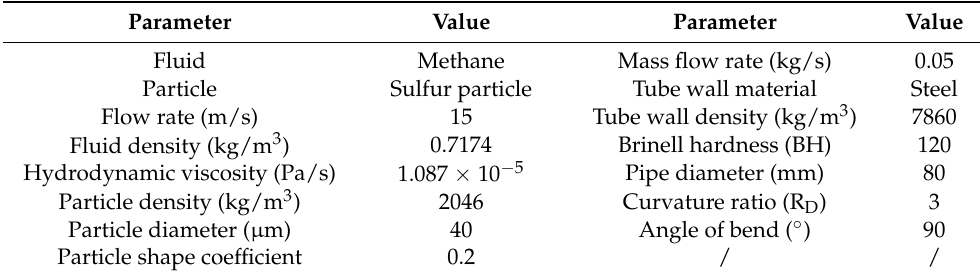
Figure 2. Schematic diagram of a geometric model of the pipeline. Table 2. Basic parameters of the